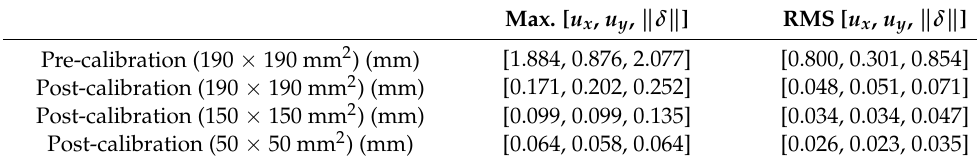
Table 1. Pre- and post-calibration results in various working areas.